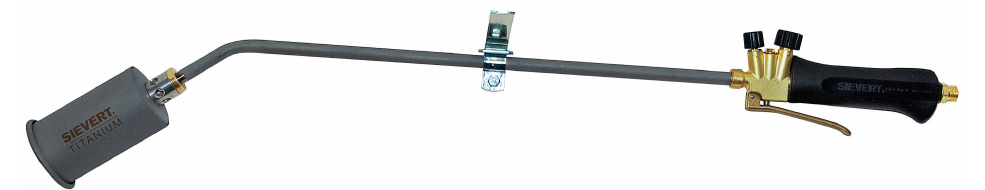
Figure 7. Propane burner (Sievert 346051, titanium 60 mm diameter).